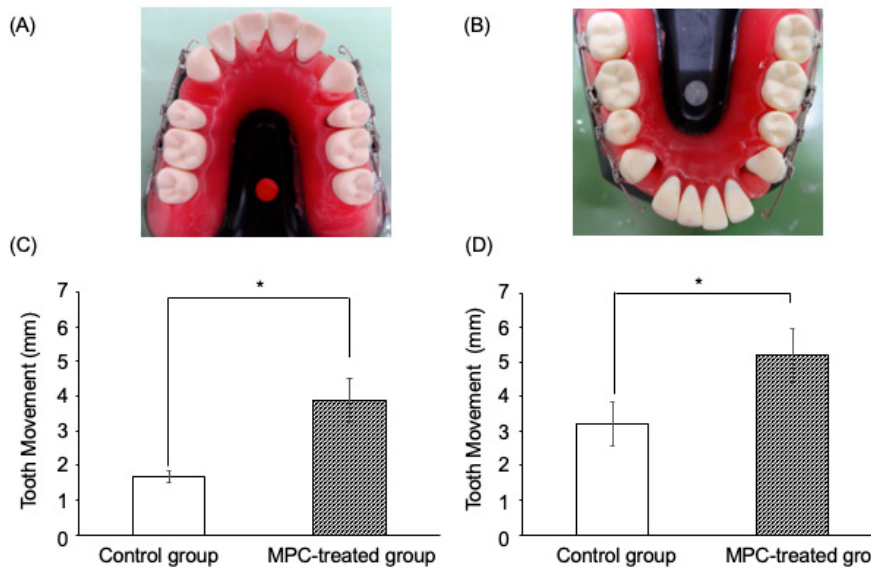
Figure 5. Effects of MPC-coated wires on experimental simulated artificial tooth movement in vitro. ( A ) The maxillary model; ( B ) The mandibular model; ( C )The results of tooth movement in the maxilla ( D ) The results of tooth movement in the mandibule.